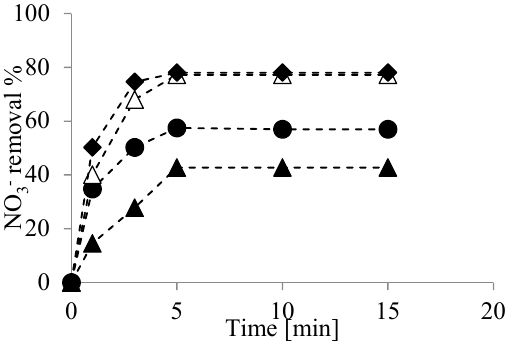
Figure 8. Nitrate removal at different temperature conditions: 283 ( ▲ ), 298 ( ● ), 303 ( Δ ), and 313 K ( ♦ ). Condition: unbuffered pH, 0.1 g L − 1 bimetallic nanoparticles, and [NO 3 − ] = 300 mg L − 1 .